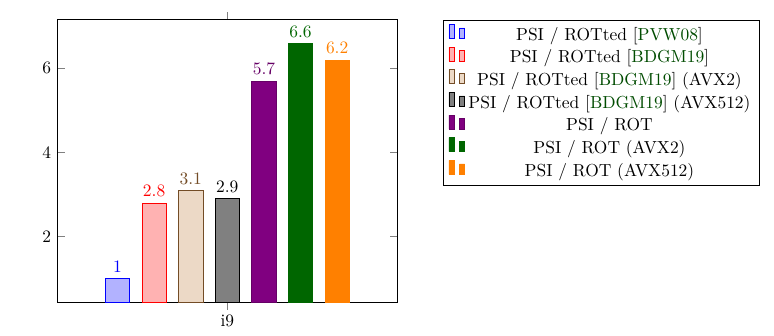
Figure 8: PSI speedup results for the x86_64